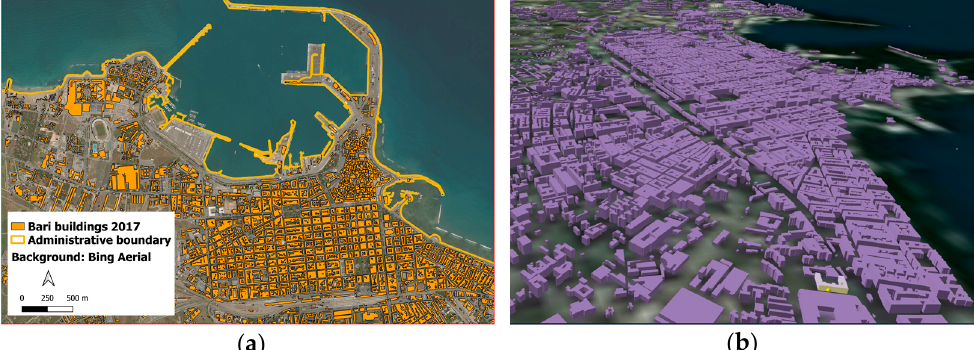
Figure 7. Close-up from Bari municipality of: ( a ) building layer and ( b ) 3D model obtained by combining LiDAR and building layers.